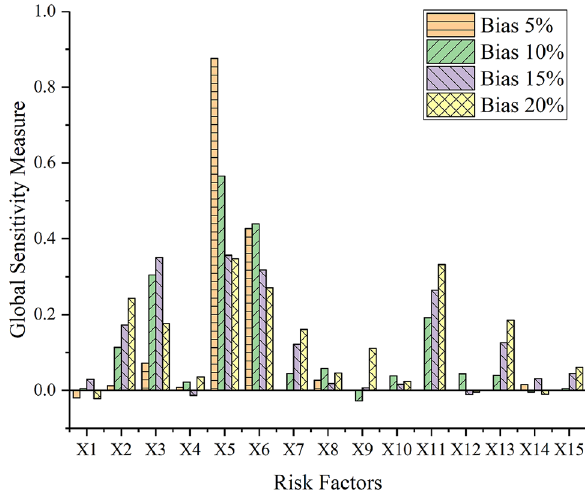
Figure 9. Global sensitivity analysis of 15 risk indicators (No. 2